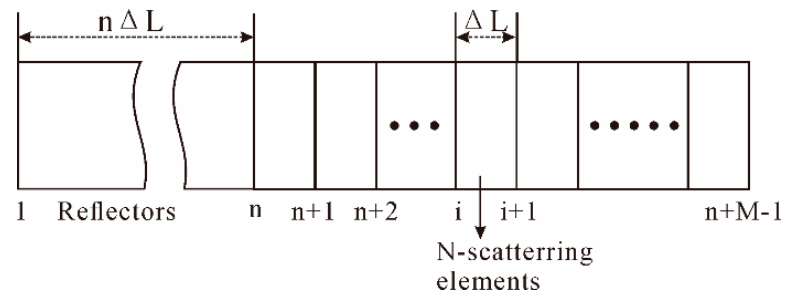
Figure 8. Discrete model of Rayleigh backscattering light, adapted from Park et al. [85].